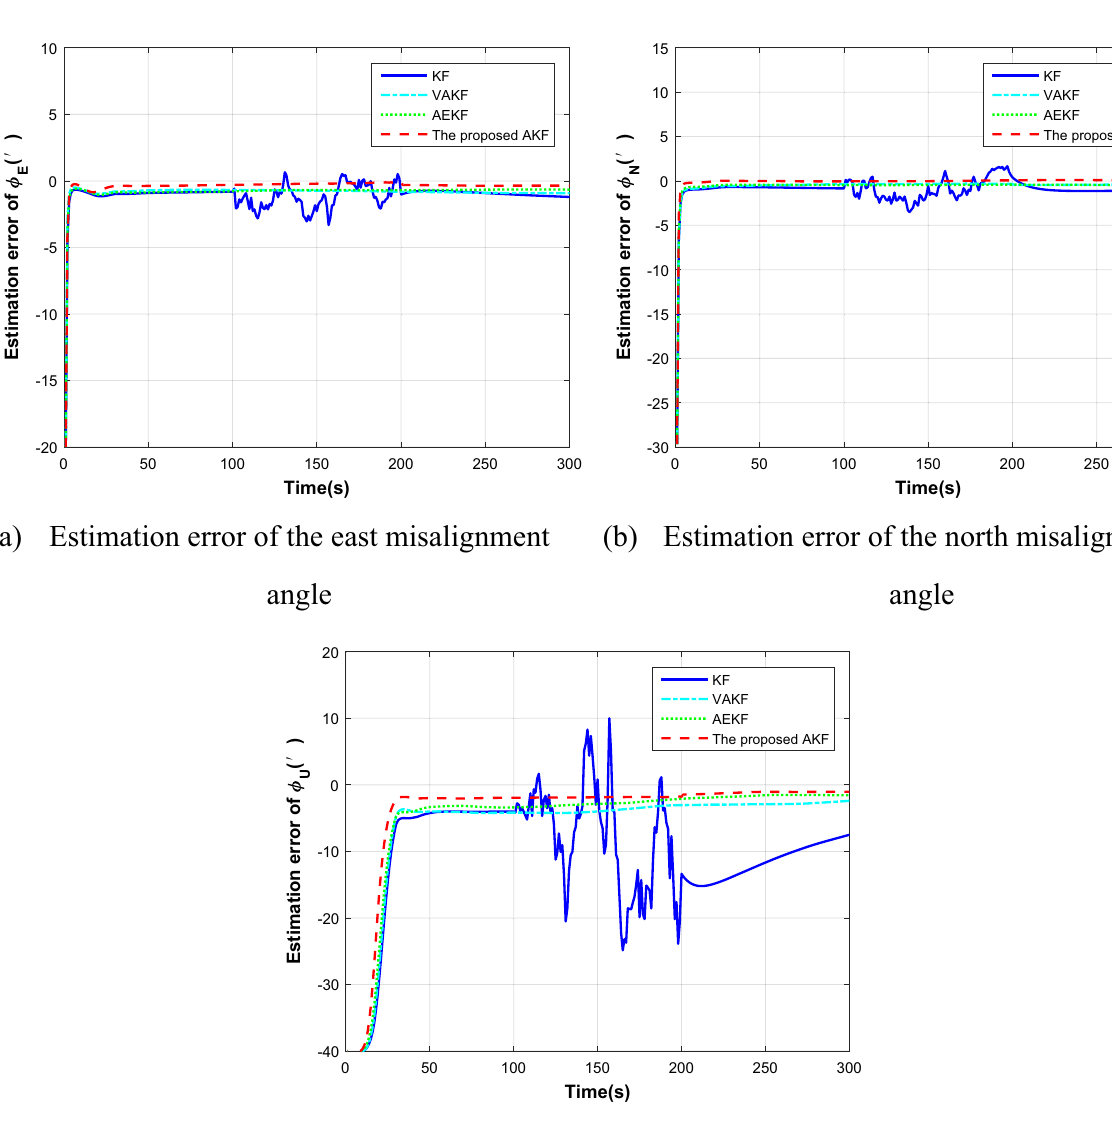
Figure 5. Misalignment angle estimation comparison with abnormal noise